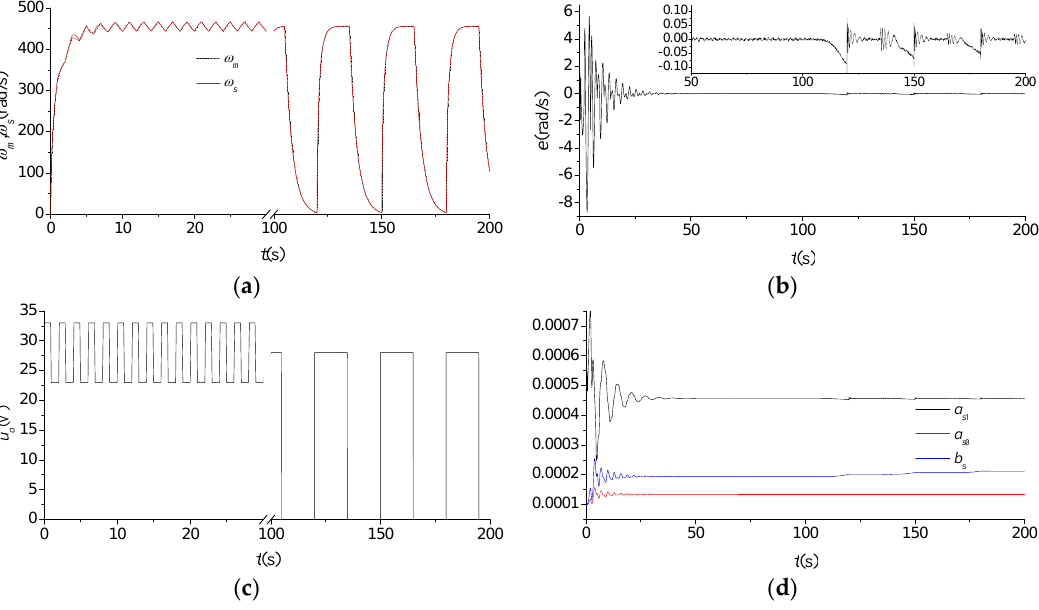
Figure 6. Experimental results for the input square wave. ( a ) ω m and ω s ; ( b ) e ; ( c ) u a ; and ( d ) the parameters of the soft sensor.